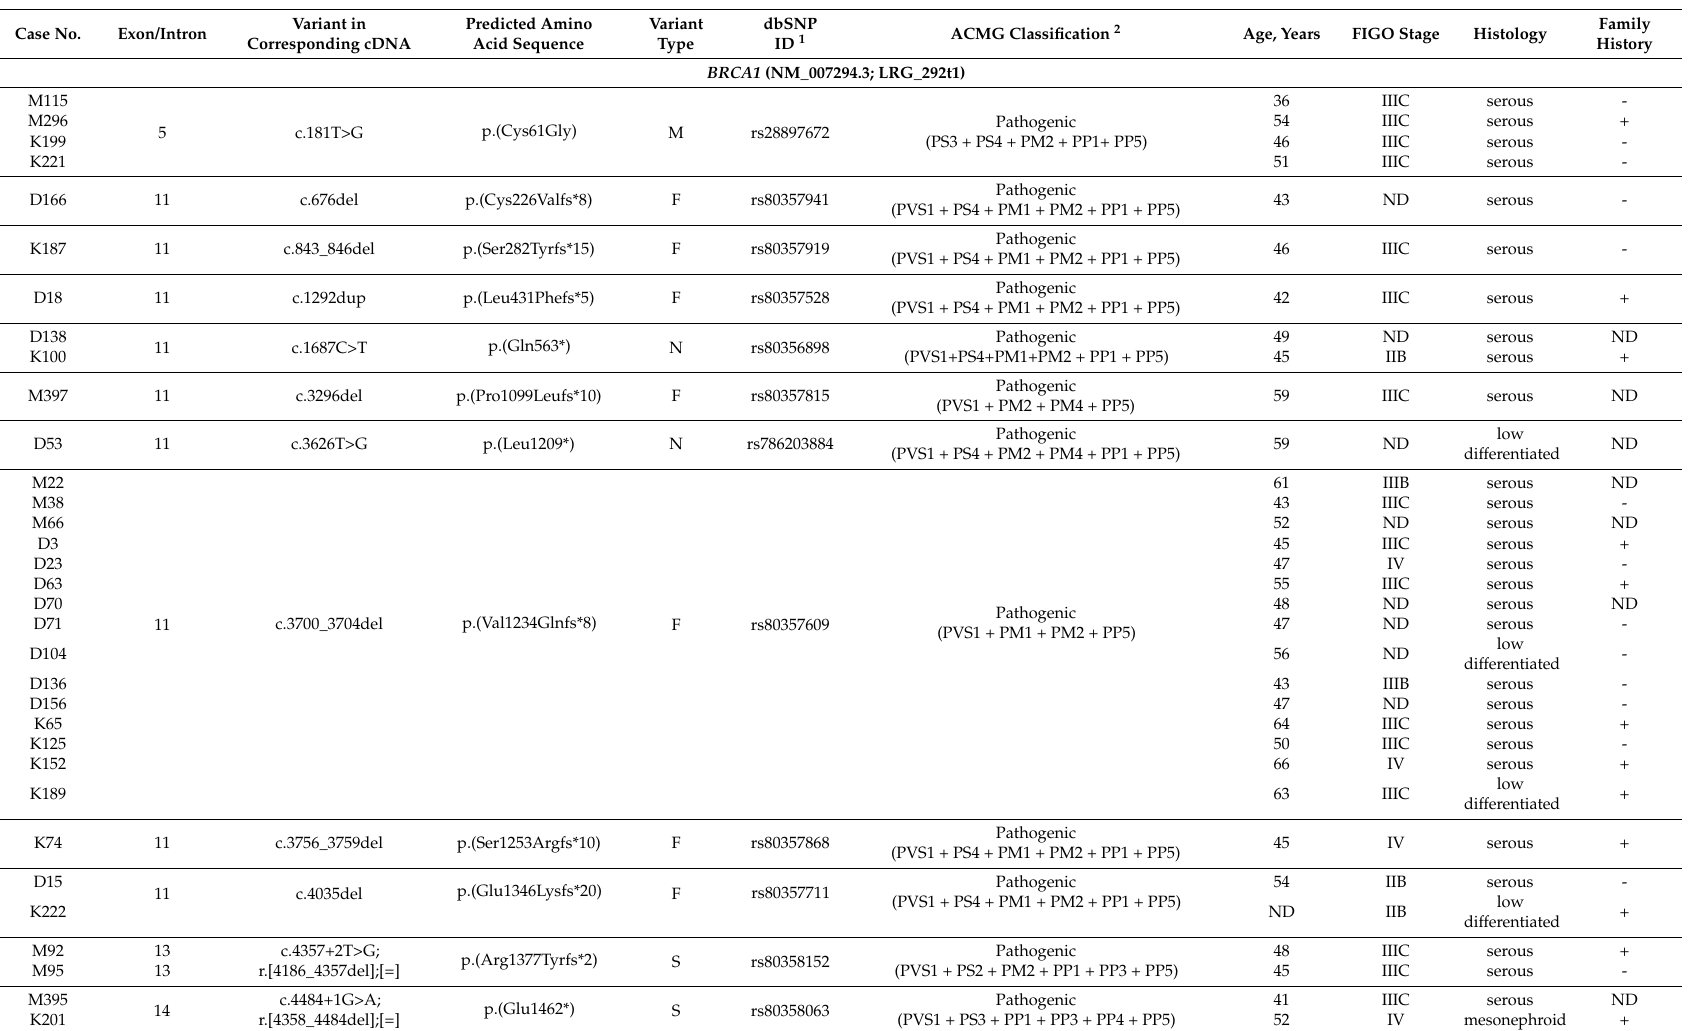
Table 1. Clinical, histopathological and molecular data of the ovarian cancer individuals heterozygous for the BRCA1/2 pathogenic variants. Case